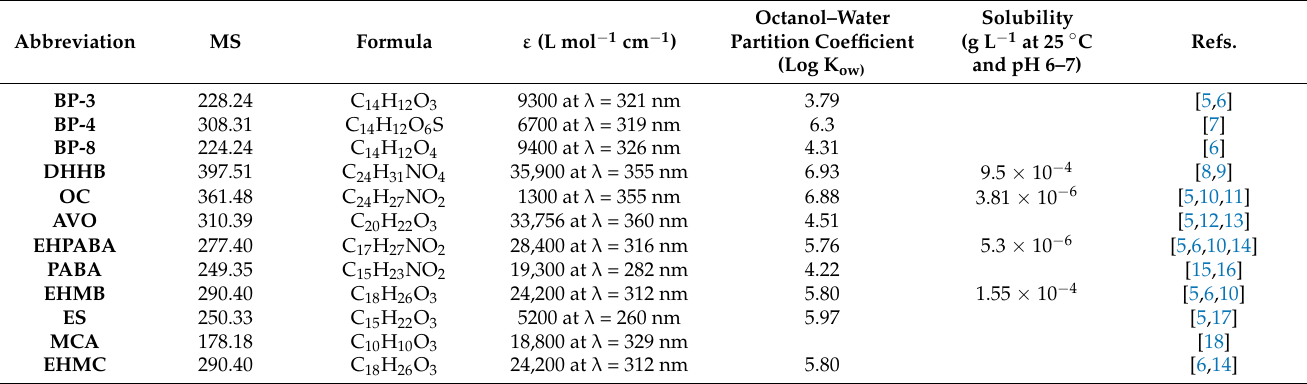
Table 2. Some chemical and physical characteristics of the solar filters